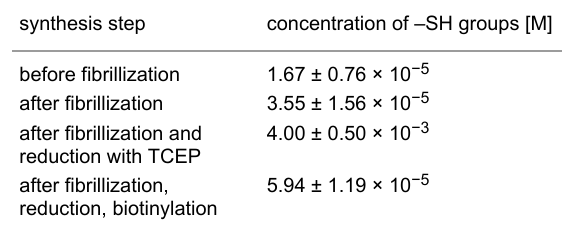
Table 1: Detection of sulfhydryl groups during modification of α -SynC141 fibrils. The initial concentration of α -SynC141